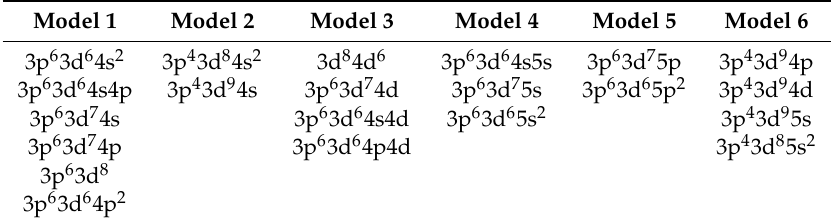
Table 1. Six models of the iron atom, described by their configuration sets. Each model adds to the previous configuration